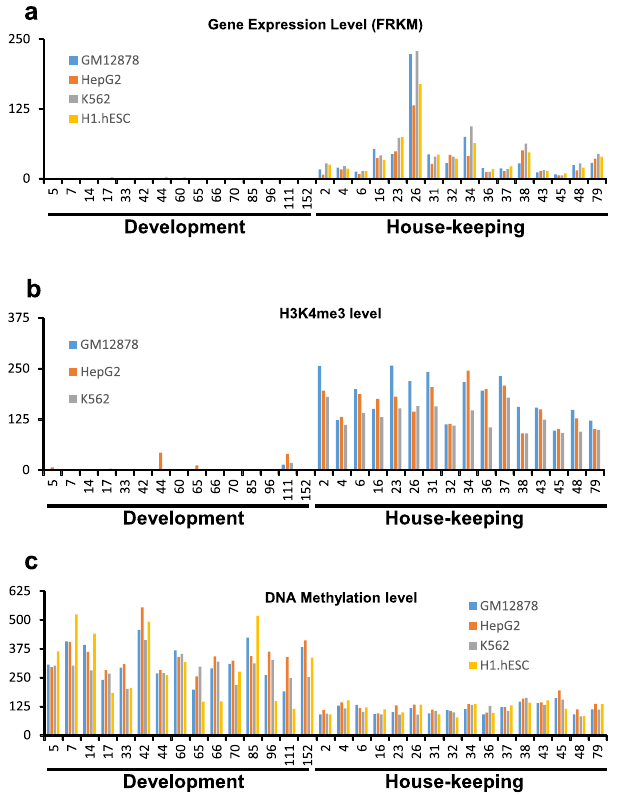
Figure 4. Gene expression and epigenetic regulation of Sp1 motif regulated modules. ( a ) The median gene expression level for genes within the Sp1-regulated modules in four human cell lines. The module numbers shown in X-axis are related to development and house-keeping categories described in Table 2. FPKM values from RNA-Seq experiments conducted by the ENCODE project is used as Y-axis. ( b ) The median H3K4me3 level in the promoters for genes within the Sp1-regulated modules in three human cell lines used in the ENCODE project. ( c ) The average promoter DNA methylation level for the genes within the Sp1-regulated modules in four human cell lines used in the ENCODE